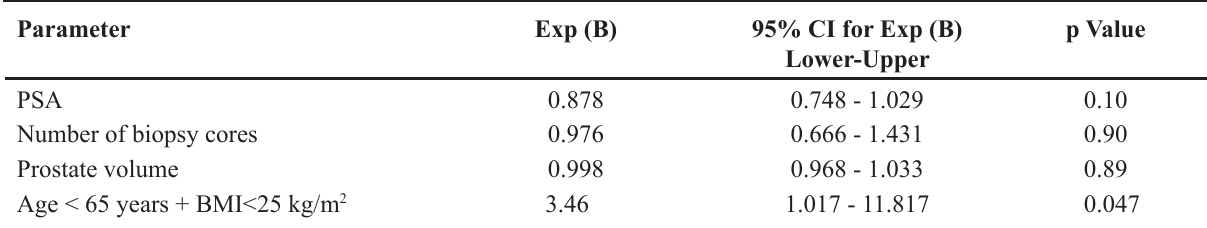
Table 3 – Multivariate analysis of predictors of bleeding in patients on low-dose aspirin.